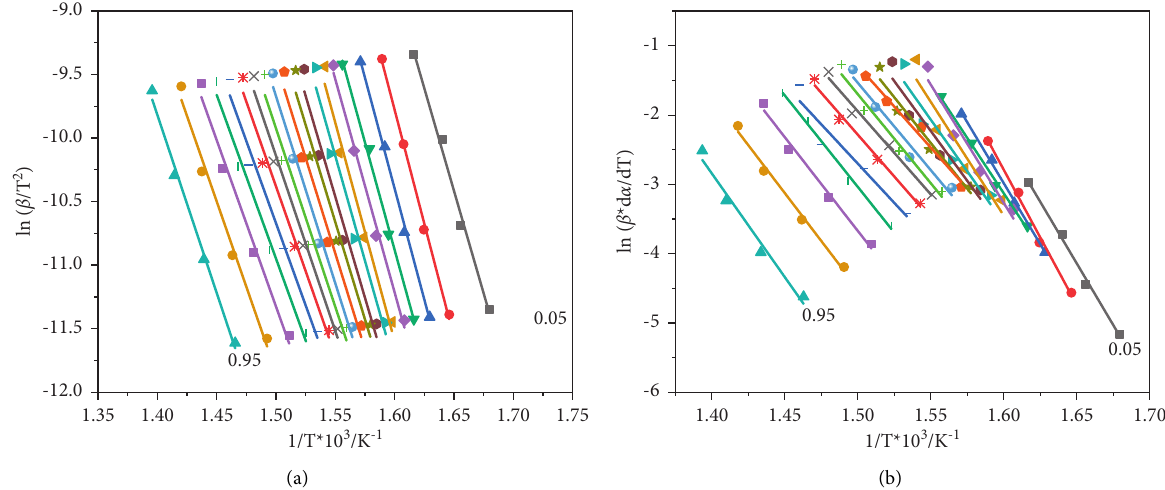
Figure 3: Graphical dependences of the Kissinger–Akahira–Sunose (a) and Friedman (b) equations for the p-EGF:AA copolymer at heating rates of 2.5, 5, 10, and 20 ° C/min.